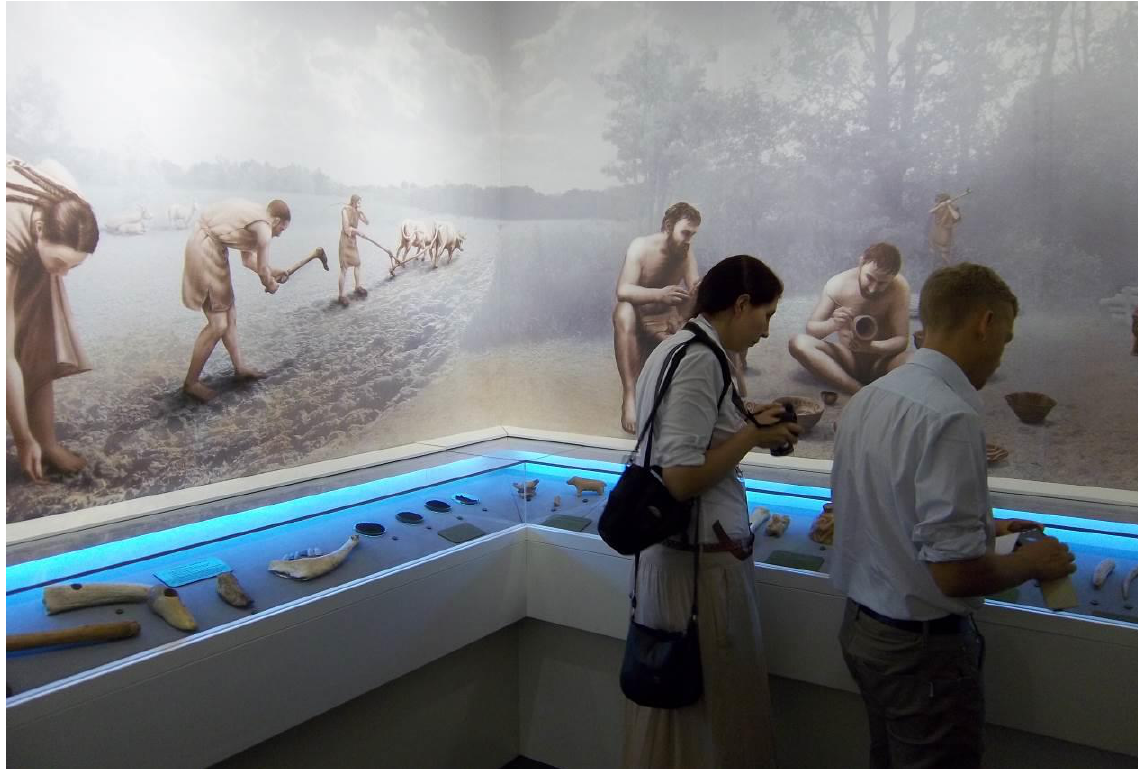
Figure 2. A visit to the Cucuteni Civilisation Museum. (Photo by Otis